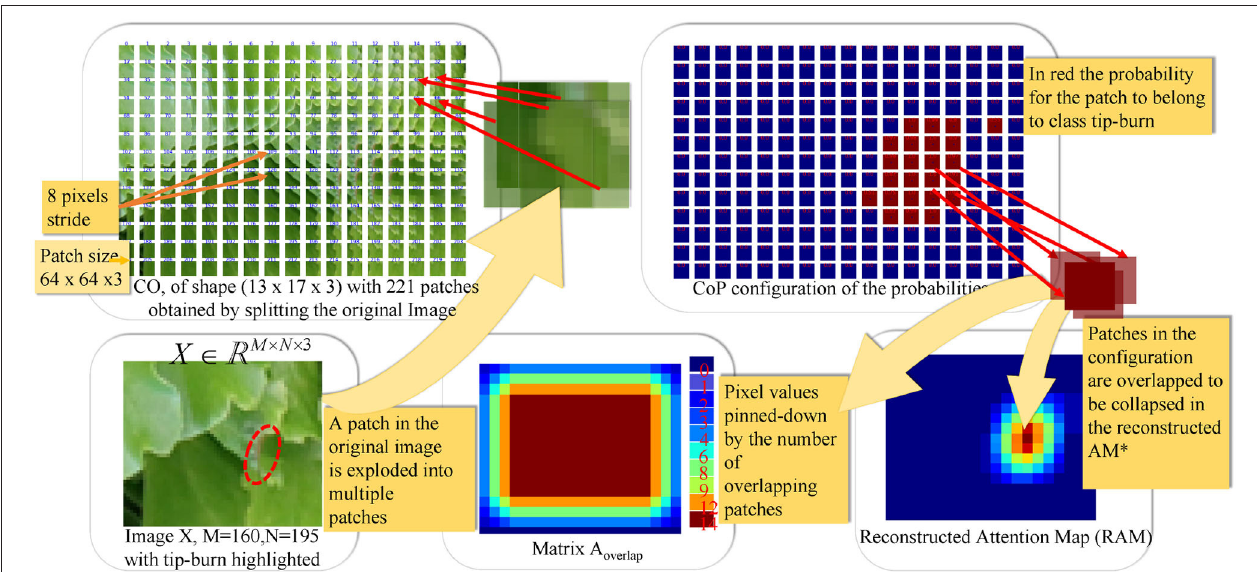
FIGURE 5 | The figure illustrates the splitting process and patch classification taking as an example an image X ∈ R M × N × 3 , with M = 160 and N = 195. The first plate above shows the configuration CO obtained by splitting X into patches of size p x × p y × d and a stride ( s x , s y ) with p x = p y = 64, d = 3 and s x = s y = 8. In the example, CO has a configuration of k 1 × k 2 patches, with k 1 = 13 and k 2 = 17. The plate on the upper-right shows the configuration of probabilities CoP obtained via the softmax by classifying each patch in CO. CoP has the same shape as CO, by fine-tuning Resnet50V2. The plates below, on the right of the image X , show the matrix A overlap ∈ R M × N , collecting the number of times patches overlap on a pixel when collapsing the configuration into the reconstructed image, according to the stride. The Reconstructed Attention Map (RAM) is obtained by collapsing CoP, and it has the same size as X